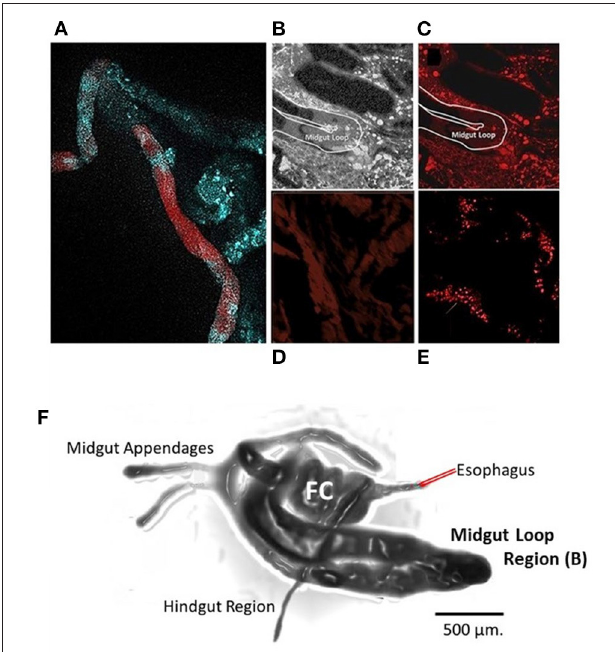
FIGURE 2 | Citrus cutting feeding assay using FANA Fluorescence probe. Adult psyllid were fed on new citrus growth that absorbed solution of FANA with fluorescent probe or water. Feeding access periods were 48h (A) , 5 and 7 d (B,C) . The midgut (A) of adult psyllid 48h after feeding access on treated citrus leaf. The lumen of the midgut becomes void of fluorophores when examined after 7-day feeding access on untreated citrus leaf. (C,F) midgut (Loop). The tagged FANA were observed in a variety of tissues at 7 d after feeding, indicative of systemic movement into cells of tissues, and vesicles in the psyllid body (E) (Red). Control untreated psyllid sample shows level of background fluorescence (D) . Drawing of dissected psyllid alimentary tract (F) provides perspective of location of the midgut loop shown in (C) . Filter chamber (FC). Samples were viewed within 48h after being mounted on glass slides, with a Zeiss LSM510 Confocal Microscope (Smithsonian Marine Station, Fort Pierce, FL). Image (A) separate sample preparation method as in Sandoval-Mojica et al. (2020).